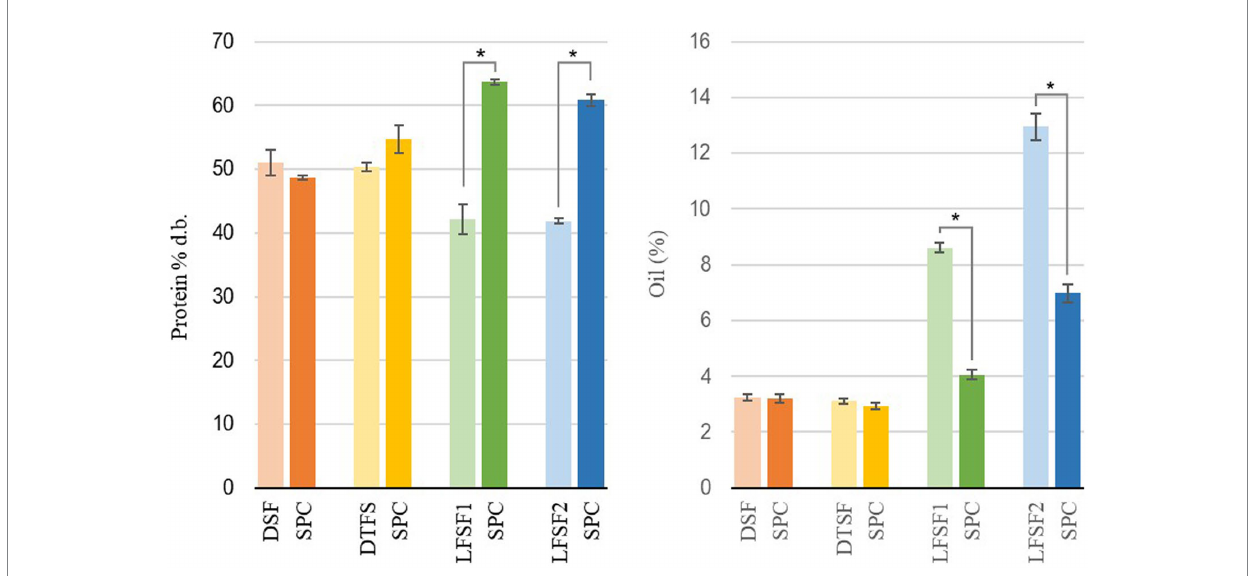
FIGURE 2 Total protein (left) and oil content (right) of raw materials and their soy protein concentrates (SPC) produced at lab scale (30 min, 22 ° C). Symbol (*) represents a statistical difference between the raw material and its SPC (Fisher’s LSD test; p < 0.05).